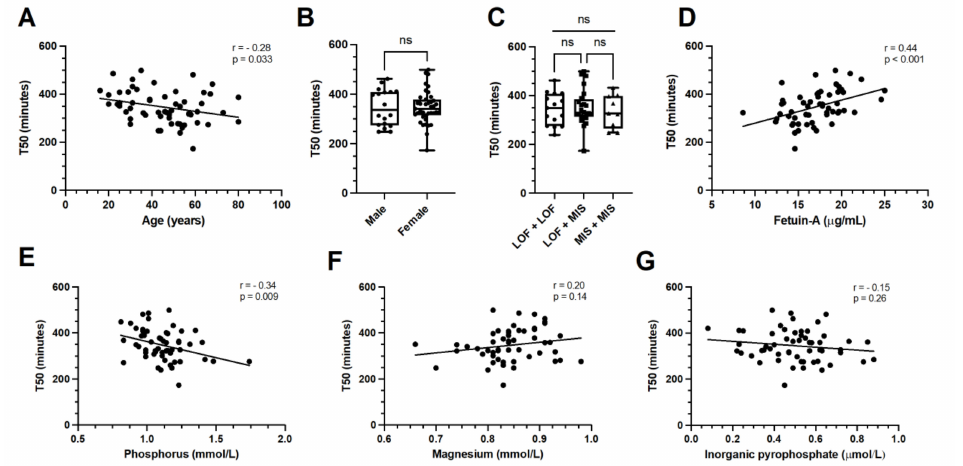
Figure 1. Associations of baseline characteristics with serum calcification propensity T50 in PXE. T50 significantly correlated with age (panel ( A )), but not with sex or ABCC6 genotype (panels ( B , C )). Serum fetuin-A levels correlated strongly and positively with T50 (panel ( D )). An inverse correlation existed between T50 and serum phosphorus levels (panel ( E )), while only a trend towards correlation was identified with serum magnesium levels in univariate analysis (panel ( F )). Plasma inorganic pyrophosphate did not significantly correlate with serum T50 in PXE patients (panel ( G )). LOF—loss-of-function variants; MIS—missense variants; ns—non